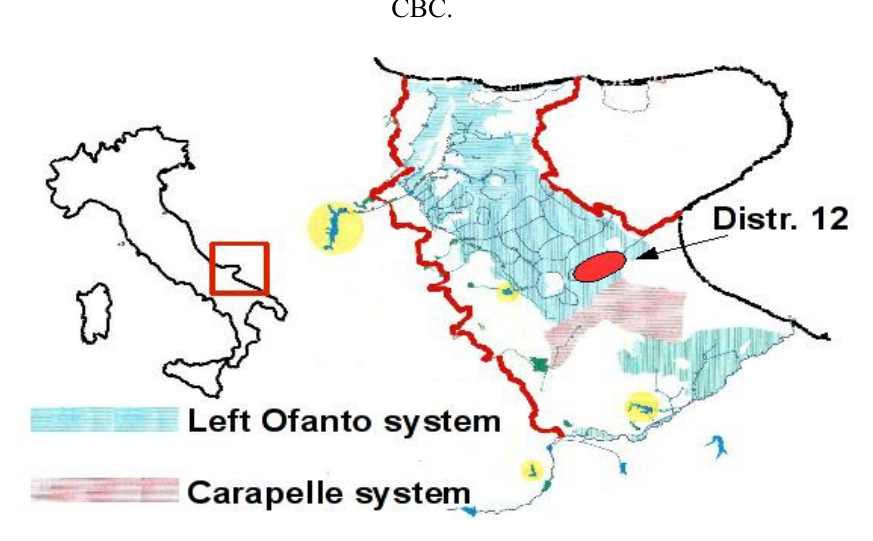
Figure 1. The study area (Apulia region, Foggia province). The faded area is served by the